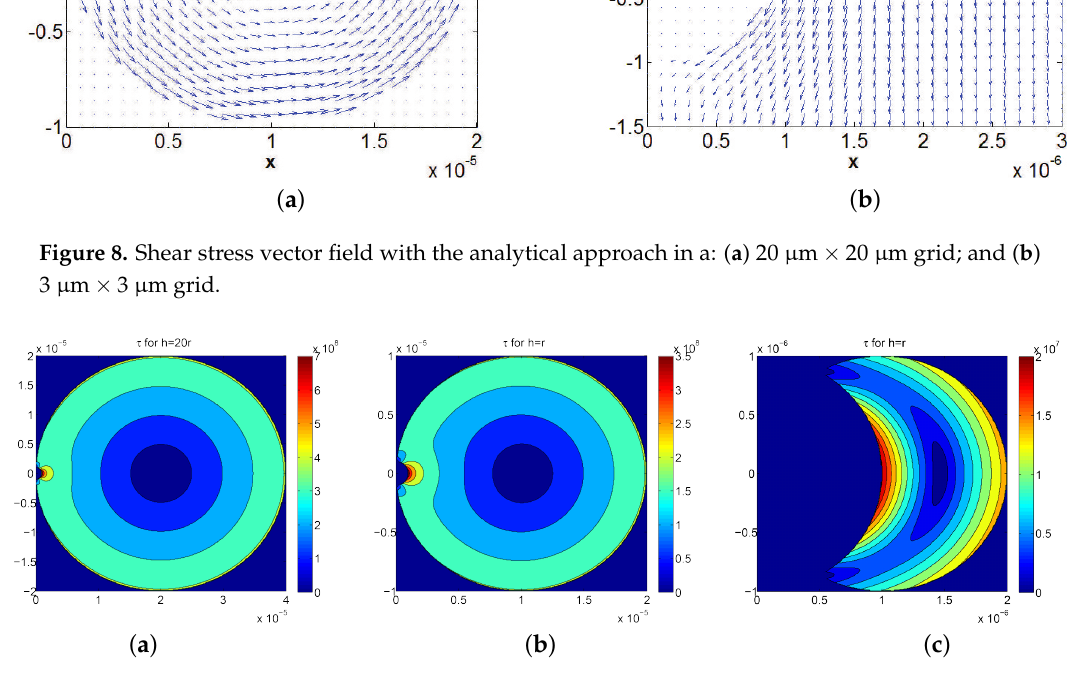
= 20 ( a ); h = 10 ( b ); and h = 20 ( c ). r r r